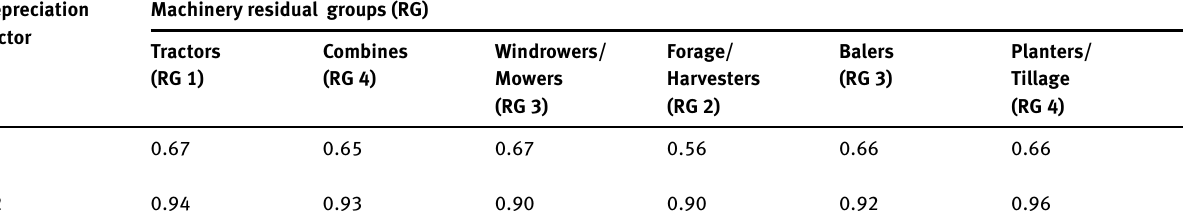
Table 2: Depreciation factors for calculating remaining value percentages by machinery group Depreciation